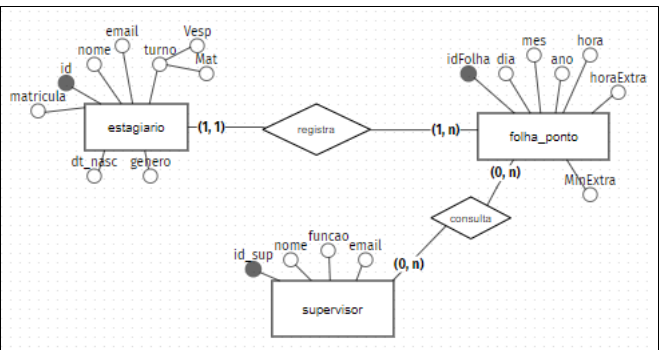
Figure 4: Process of storing the system data.